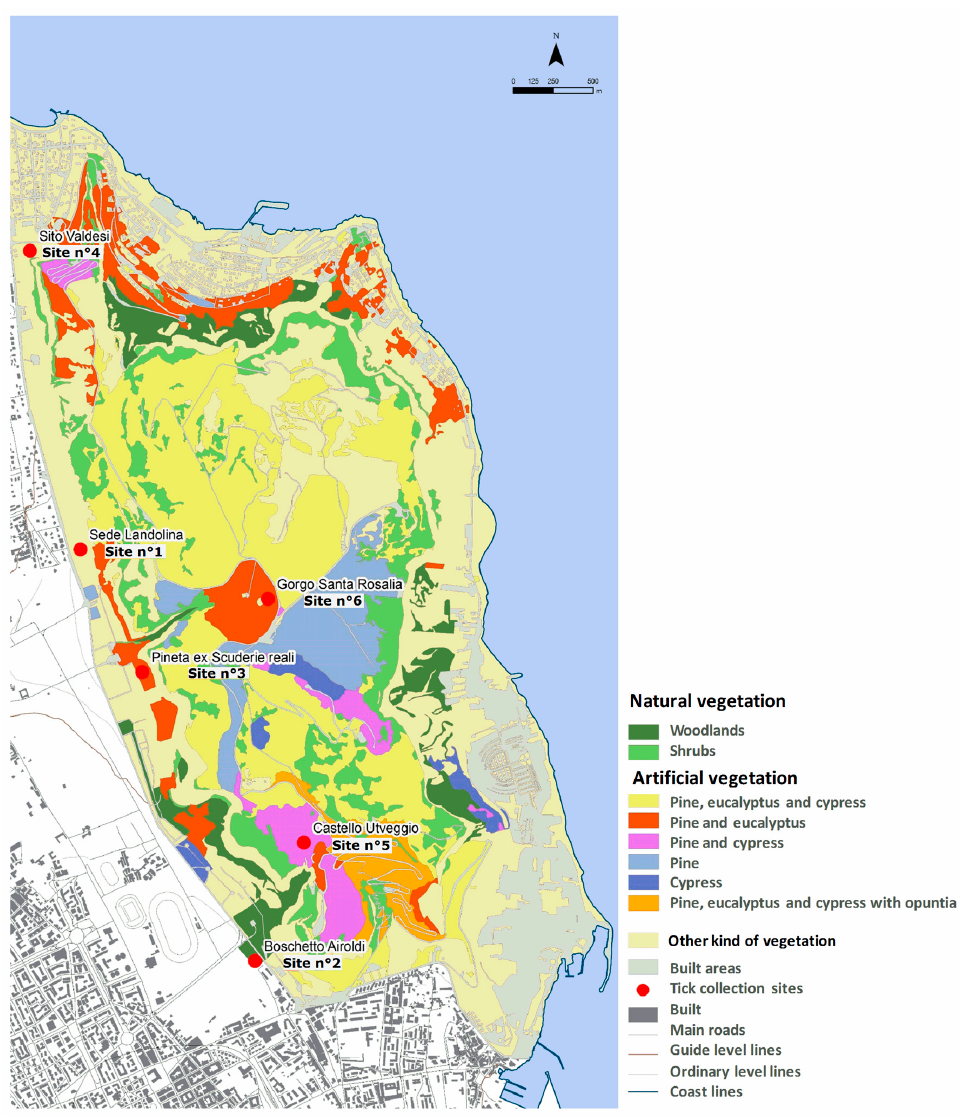
Figure 5. Forest vegetation map of Monte Pellegrino.